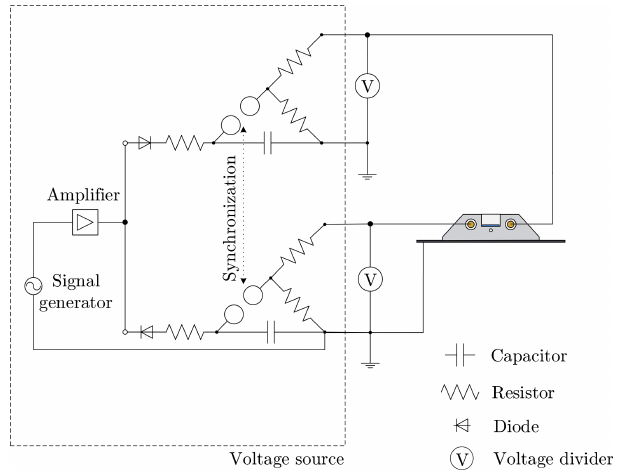
Figure 6. Schematic wiring diagram of the system for power supply used to generate a transient electric field with high initial peak field strength and a continuous decay of the field strength.